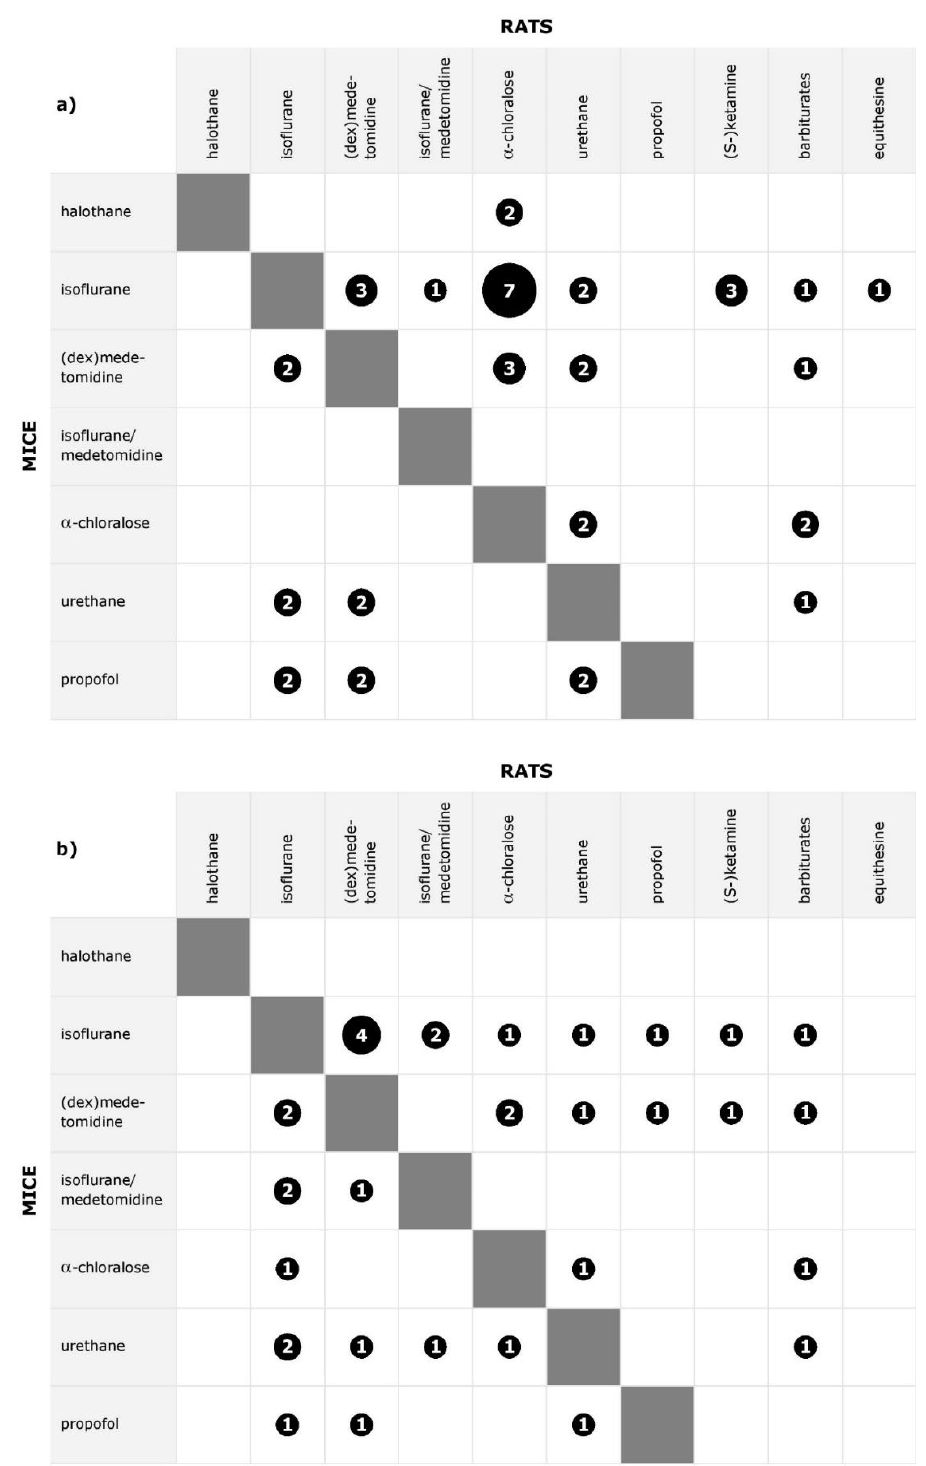
Figure 3. Distribution of pairwise comparisons of anesthetics for ( a ) stimulation fMRI and ( b ) rsfMRI. The size of the symbol represents the total number of datasets; the number of references may be higher.